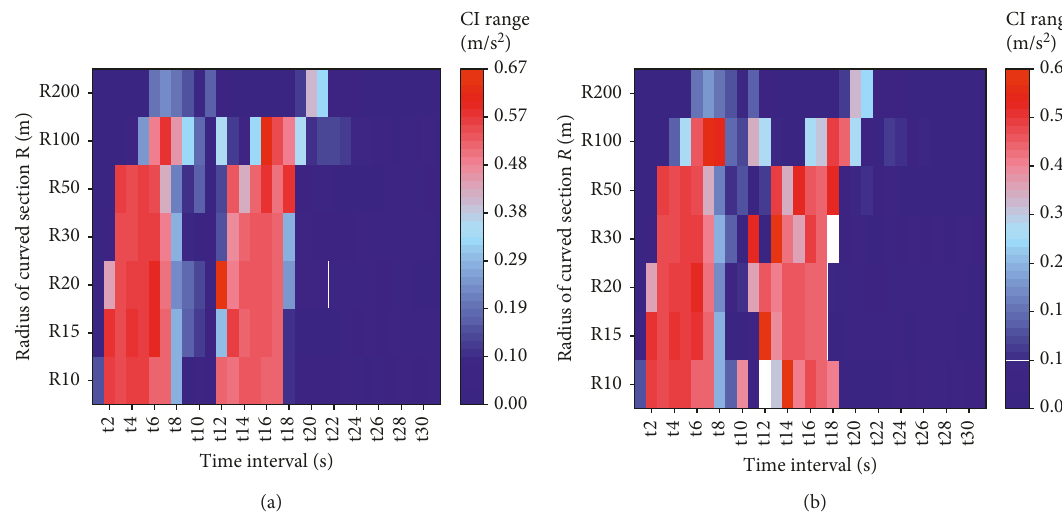
Figure 20: Matrix heatmaps of the comfort evaluation results: (a) on dry road; (b) on wet road.